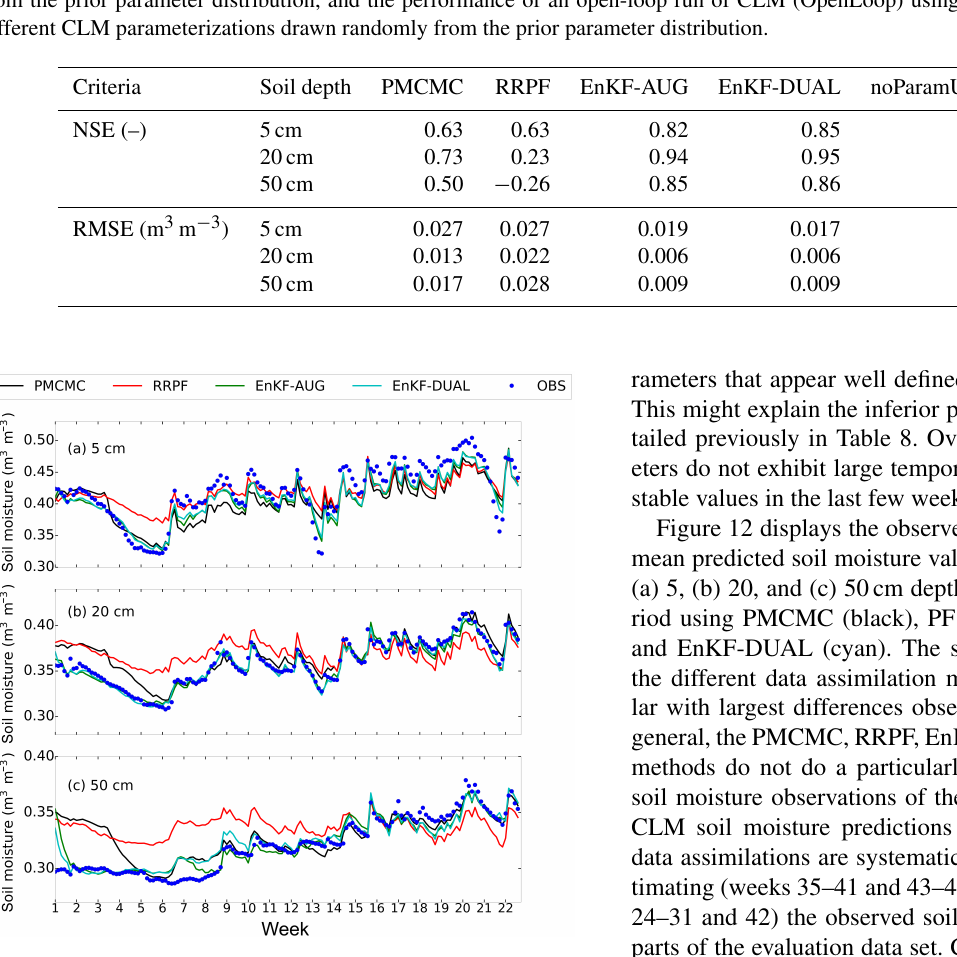
Figure 10. CLM predicted time series of soil moisture content at (a) 5cm, (b) 20cm, and (c) 50cm depth during the 5-month cal- ibration period using PMCMC (black), RRPF (red), EnKF-AUG (green), and EnKF-DUAL (cyan). The first day of week 1 is 1 March 2012 and week 22 starts with 26 July